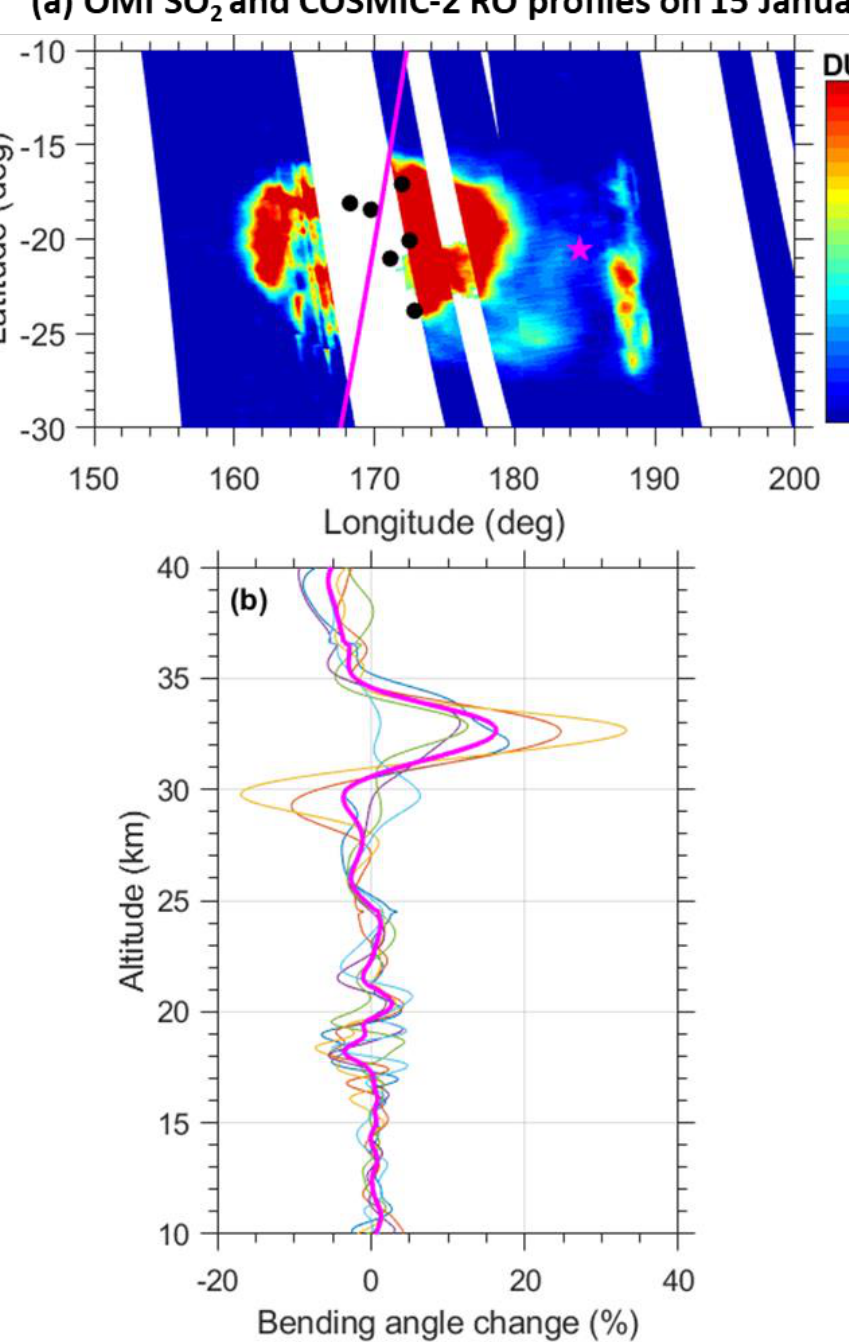
Figure 3. ( a ) OMI observed UTLS SO 2 on 15–16 January 2022 along with the available COSMIC–2 RO profiles (black dots) on 15 January. The magenta-colored line shows the CALIPSO overpass at 15:20 UTC on 15 January. ( b ) Bending angle (BA) percentage change for the aforementioned RO profiles. The mean profile of the BA change is shown in the magenta-colored profile. Table 1. Details of collocated COSMIC-2 radio occultation profiles with the volcanic cloud (OMI SO 2 ) on 15 and 16 January. The highlighted file names are related to the RO profiles that were avail- able during the eruptive stage, as shown in Figure 2.